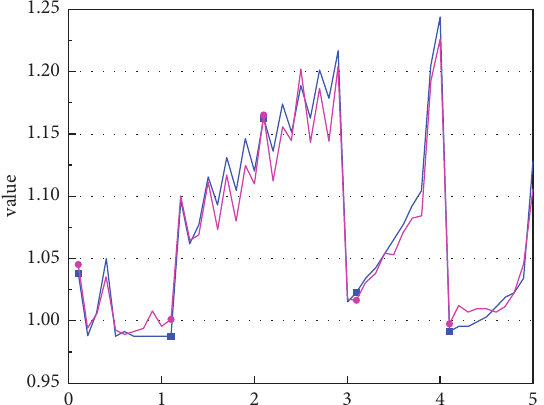
Figure 5: The predicted value of the company’s financial risk level over time by XGBoost